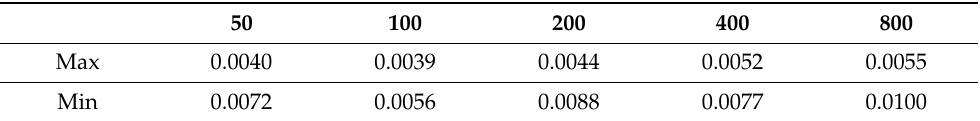
Table 6. Procrustes distances computed between vertices of ape cranial surfaces allometrically scaled to the maximum (Max) and minimum (Min) centroid size from sliding TPS and TPS&NICP semilandmarking approaches after re-semilandmarking and re-warping the template mesh.